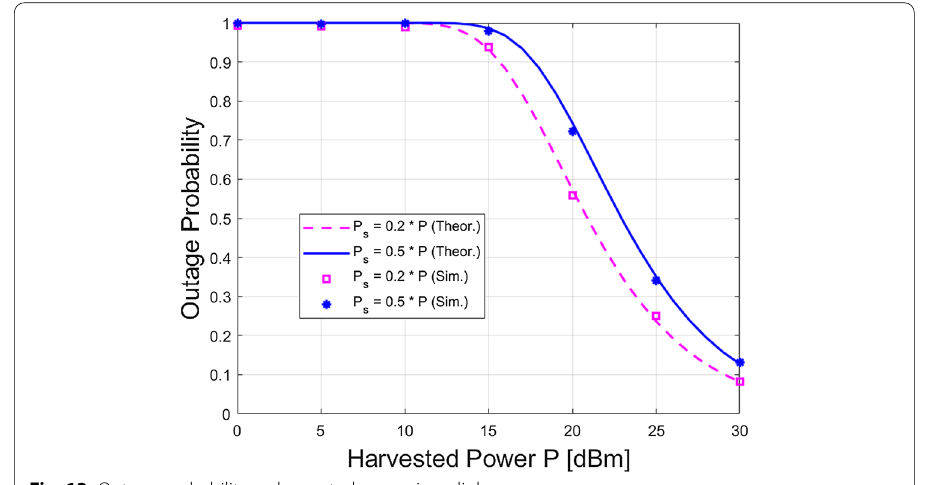
Fig. 13 Outage probability vs. harvested power in uplink